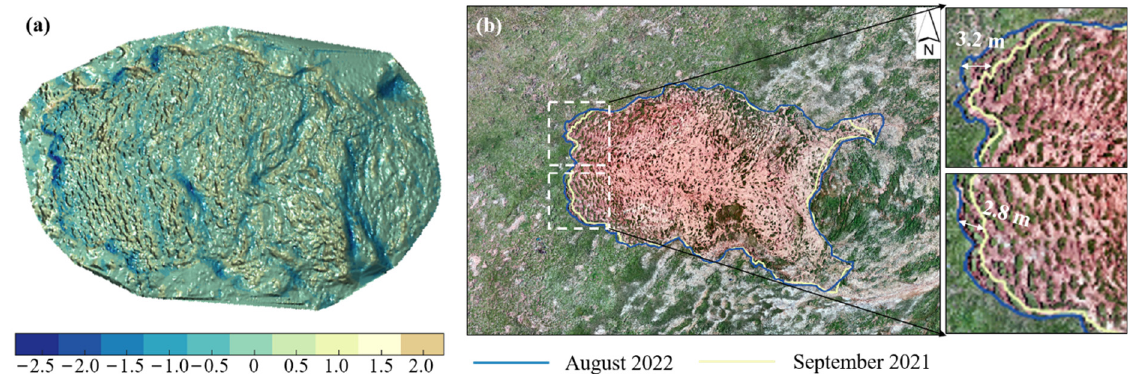
Figure 12. Surface deformation ( a ) and headwall retrogression ( b ) of the K1129W thaw slump development area using terrestrial laser scanning (TLS) and unmanned aerial vehicle (UAV).